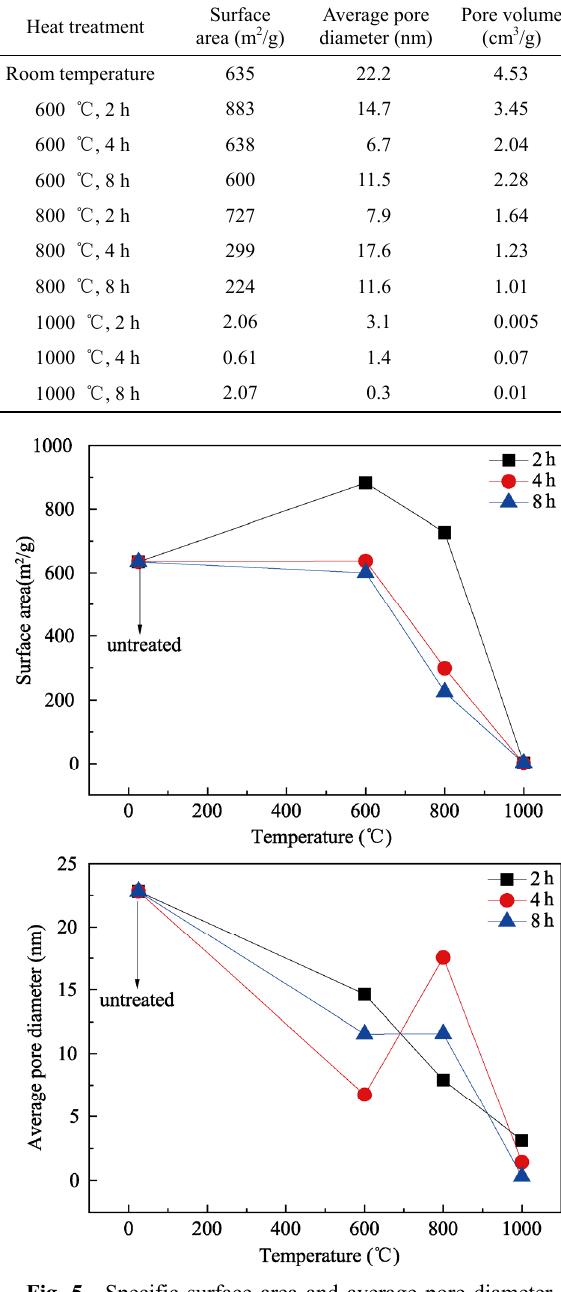
Fig. 5 Specific surface area and average pore diameter of SiO 2 aerogels treated at different